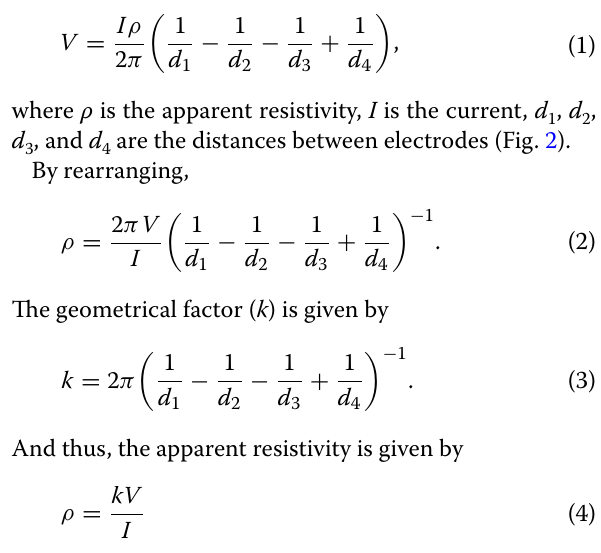
And thus, the apparent resistivity is given by